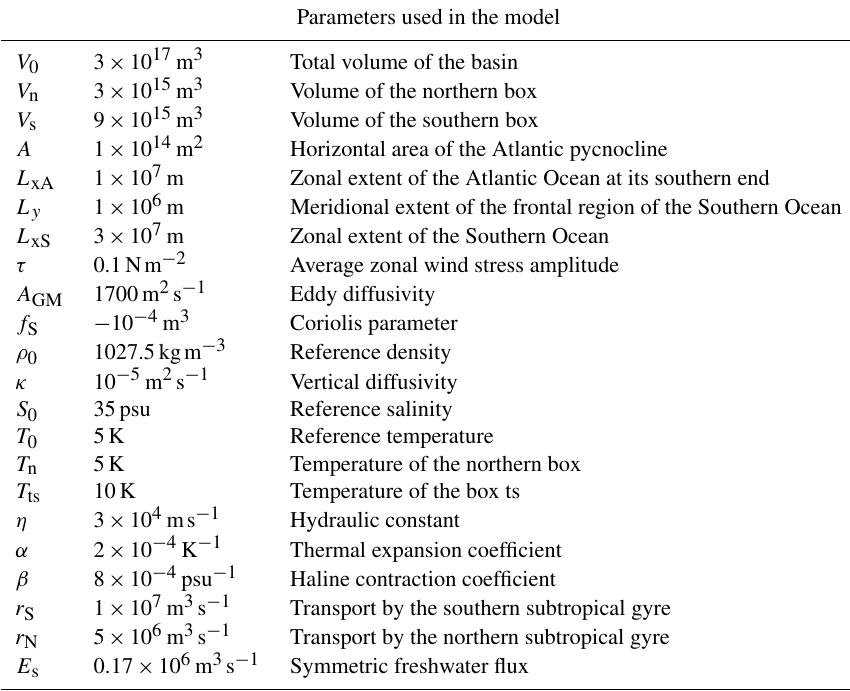
Table B1. Reference parameters used in Eqs. (B1)–(B4) from Castellana et al. (2019). Parameters used in the